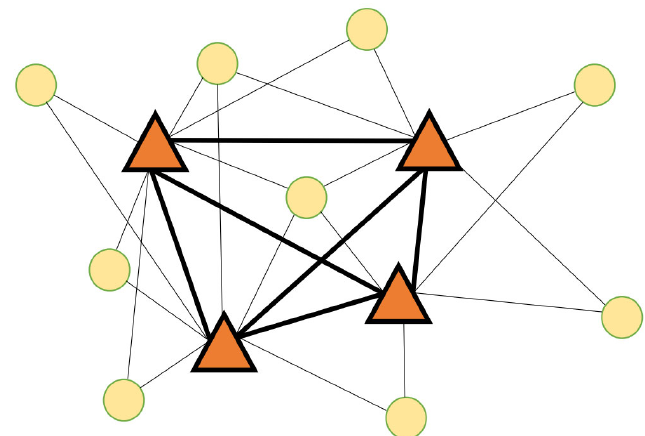
Fig. 1. Example of multiple allocation hub